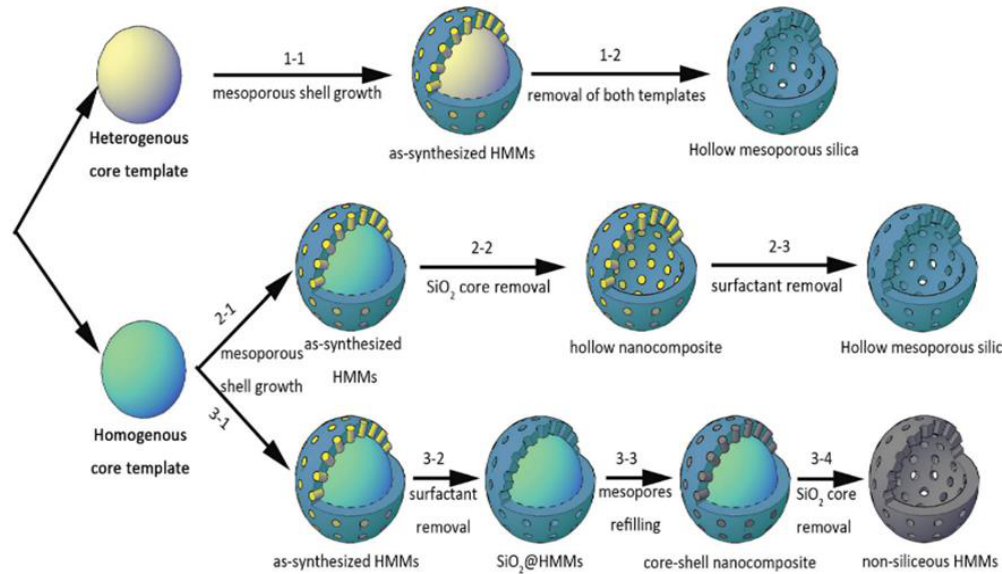
Figure 3. Illustration of the route of hard templating: (1-1) Heterogenous core, (2-1,3-1) homogenous core with the different procedures carried out to produce either hollow mesoporous silica or non- siliceous HMMs [24].